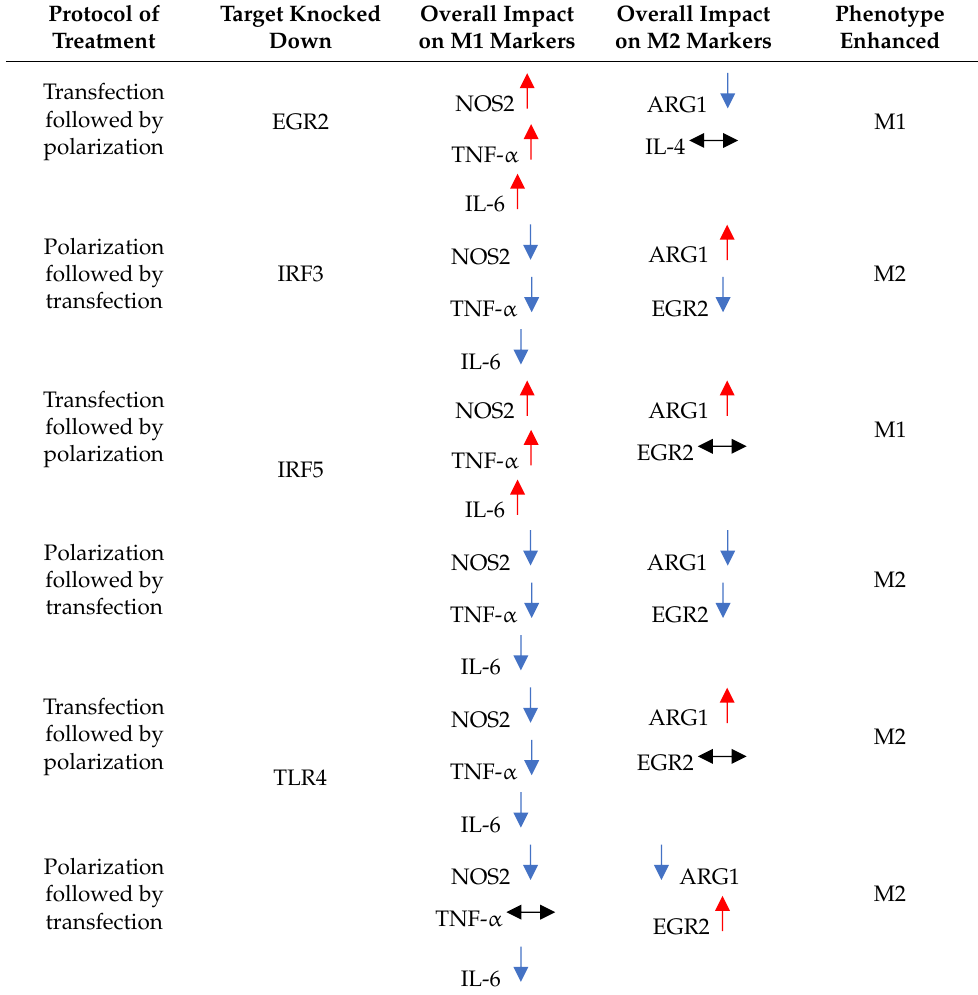
Table 1. A summary of how siRNA-mediated knockdown of selected target genes alters the pheno- type of BMDMs based on the sequence of transfection and polarization.